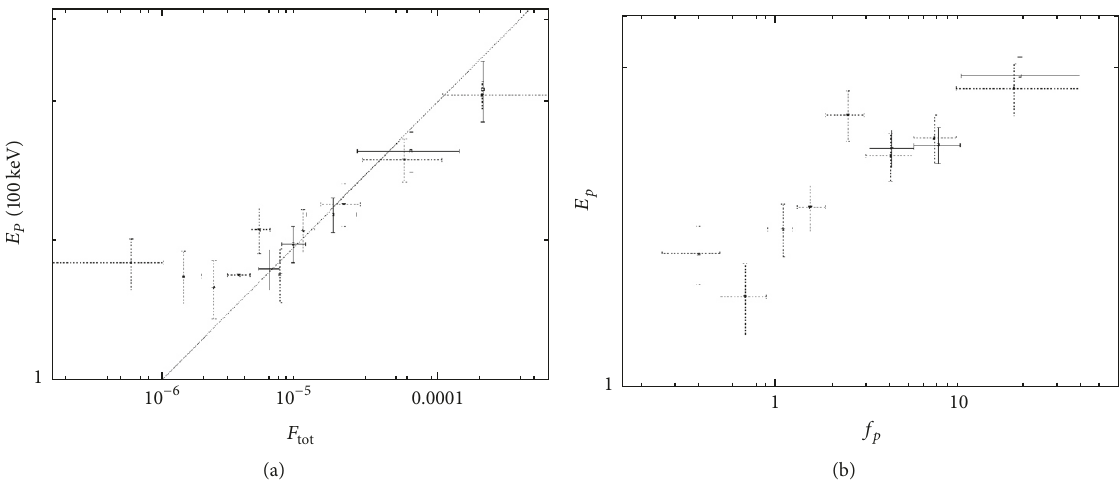
Figure 7: 𝐸 versus (a) 𝑆 and (b) 𝐹 distributions for the complete (dashed elements) and sub (solid elements) spectral sample. The peak tot peak flux suggests a tight correlation at low values, but not for the most luminous GRBs. The solid line represents a least squares fit compatible with the correlation computed by statistical methods. (Figures after Lloyd et al. [173]; see Figure 3 therein. @ AAS. Reproduced with permission.)